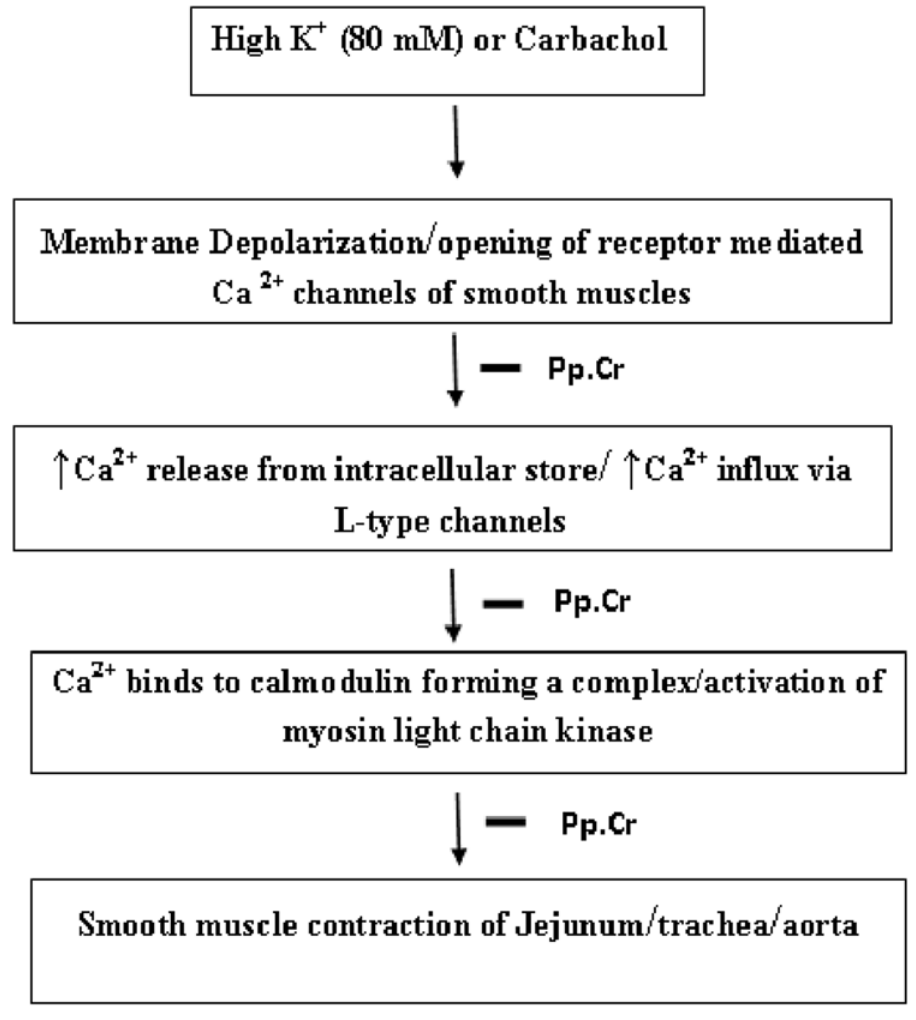
Fig 6. Proposed mechanism of action of smooth muscle relaxation mediated by ethanol extract of Pyrus pashia (Pp.Cr) against high K + (80 mM) and carbachol (1 μ M) induced contraction. Sign — indicates site of inhibition by